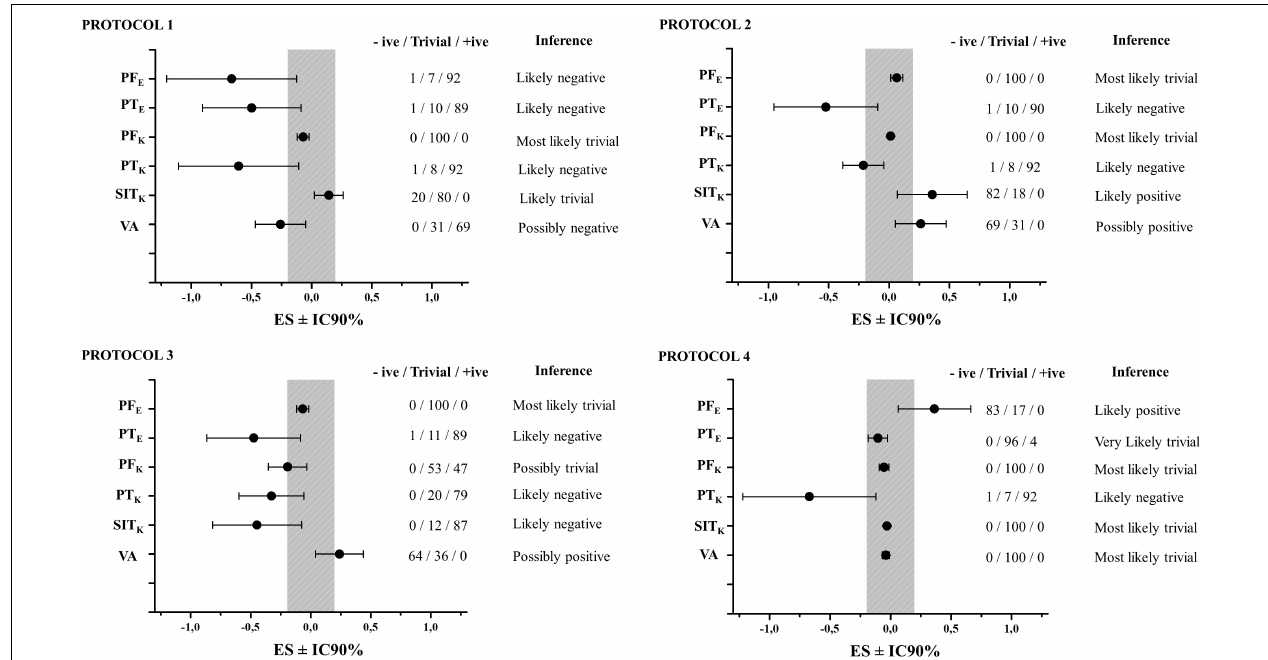
FIGURE 4 | Effect size ± IC90% values used for Magnitude Based Inferences of differences between pre and post moments for the variables obtained in the elbow and knee extension musculature in all protocols. The area in grey represents the trivial differences. PF E : Peak Force of elbow extension musculature; PT E : Peak Twitch of elbow extension musculature; PF K : Peak Force of knee extension musculature; PT K : Peak Twitch of knee extension musculature; SIT K : Superimposed Twitch of knee extension musculature; VA: Voluntary Activity; Protocol 1: standard warm-up in the pool (30 m); Protocol 2: 15 m warm-up in the pool and 1 × 3 repetitions at 85% 1RM for the lunge exercise; Protocol 3: 15 m warm-up in the poll and three maximum repetitions of pull-ups in the fixed bar and five box jumps 40 cm high and 60 cm deep wearing a vest with 10% of the body weight; Protocol 4: model proposed combining Protocol 2 and Protocol 3. M.L.Trivial: most likely trivial; L.Trivial: likely trivial; L. +ive: likely positive; L. -ive: likely negative; L. Trivial : likely trivial; P. +ive: possibly positive; P. Trivial: possibly